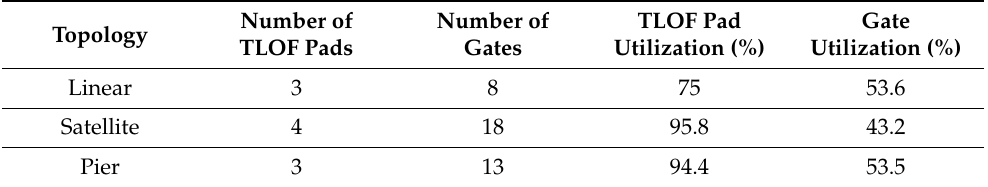
Table 8. Results of each topology for the current Gimpo parking lot space that complies with the EASA’s new regulations.